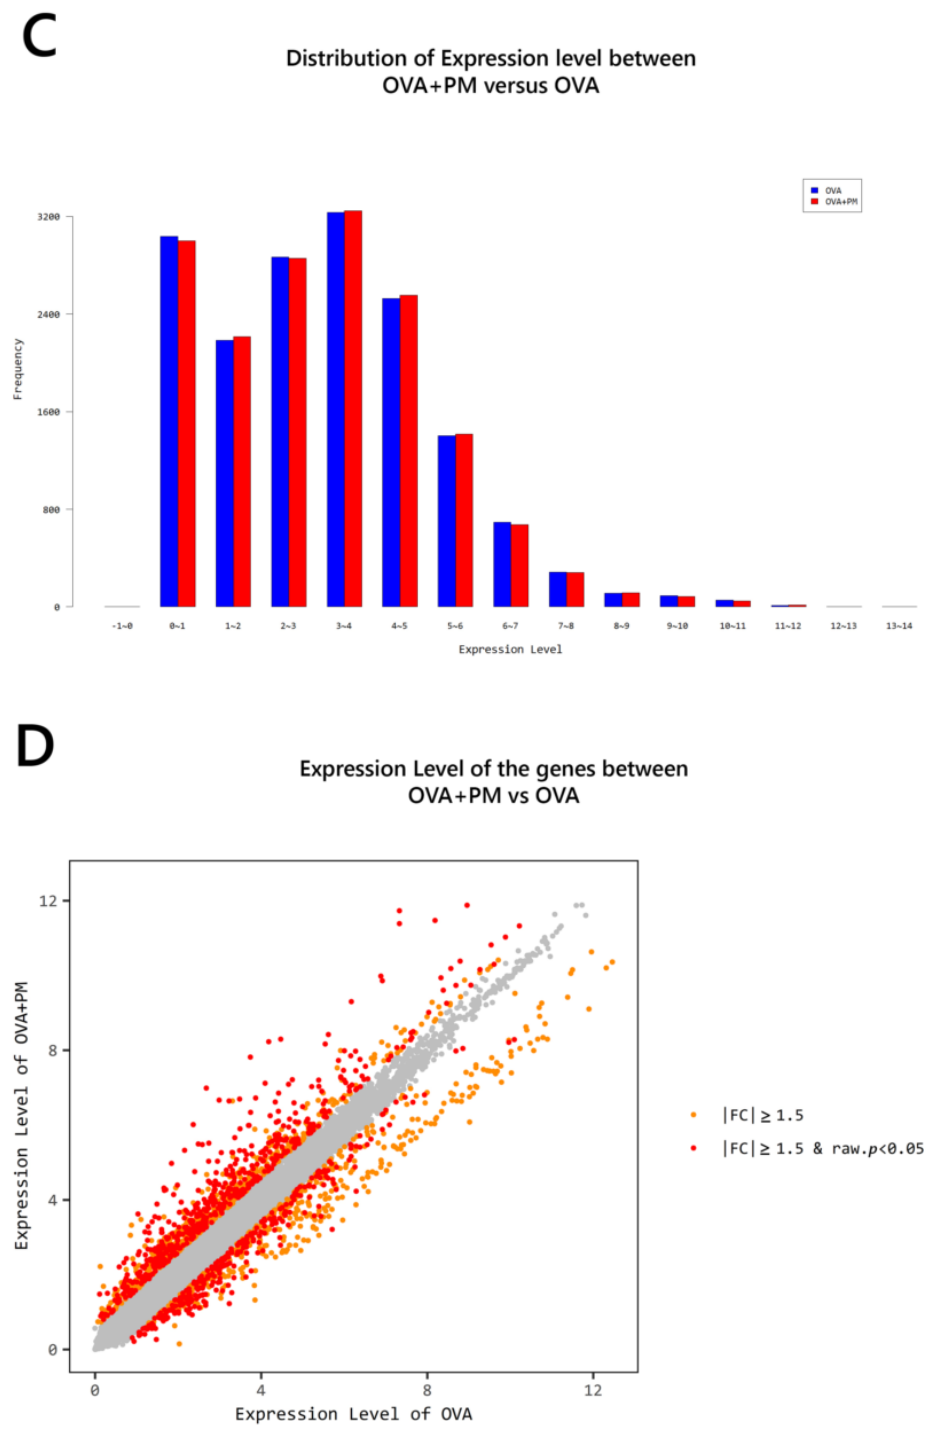
Figure 4. ( A ) Heat map of the one-way hierarchical clustering (OVA + PM vs. OVA). ( B ) Distribution of gene expression level between the OVA + PM and the OVA group. ( C ) Scatter plot of gene expression level. ( D ) Significant gene count by fold change and p -value. n = 4 in each group (OVA + PM, OVA). Only those genes exhibiting log 2 fold change (FC) ≥ 1.5 and p < 0.05 were considered differentially expressed genes. For the DEG (differentially expressed gene) set, hierarchical clustering analysis was done using complete linkage and Euclidean distance as a measure of similarity.